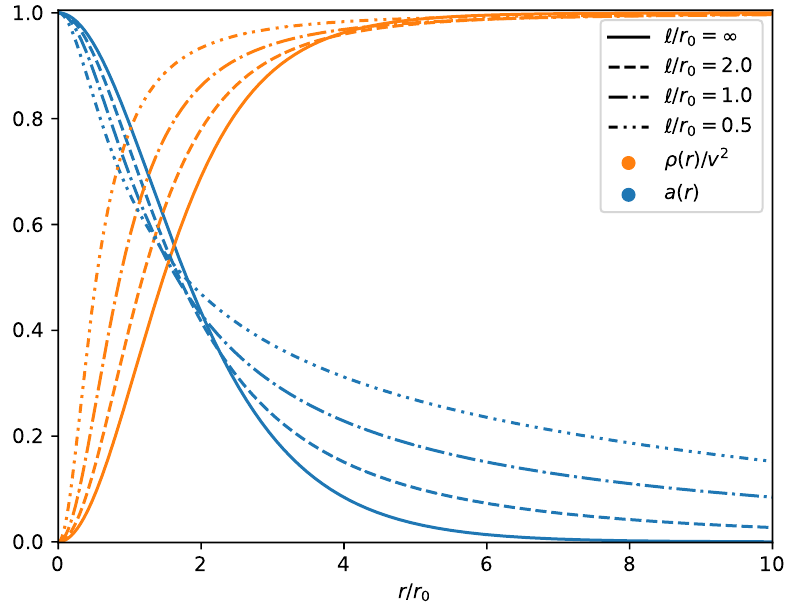
Figure 5 . Abrikosov vortex of vorticity N = 1 in fixed AdS 3 for different values of the AdS radius ‘